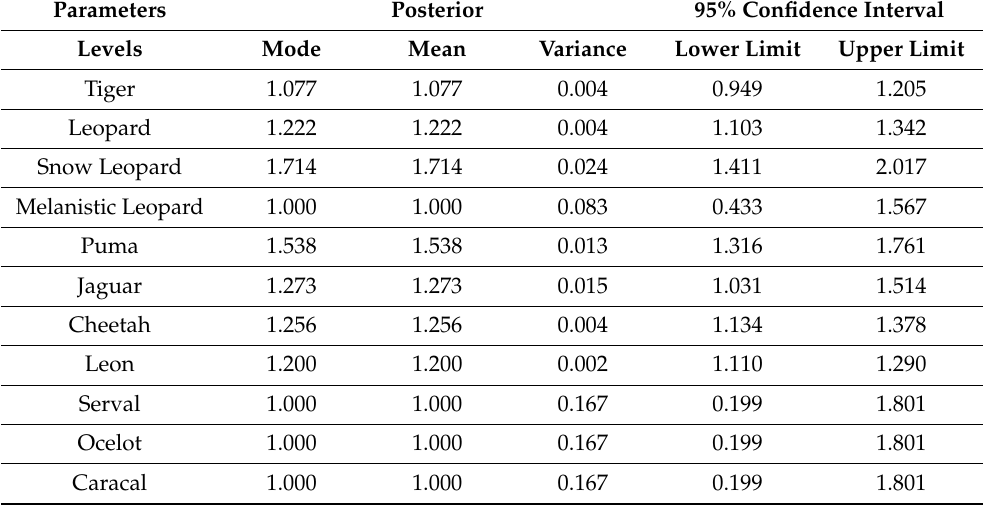
Table 4. Summary of the descriptive statistics of the posterior distribution for the predator species